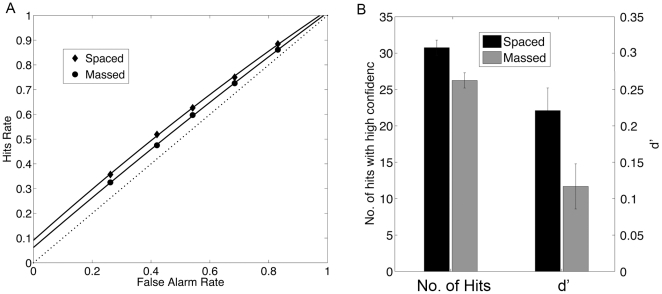
Behavioral effects of spaced learning.A. Receiver operator characteristic (ROC) curve plotted as hits rate against false alarm rate, separately for spaced and massed learning. B. Bars represent the mean number of hits with high confidence (rated as > = 5 in a 6-point scale with 1 indicating definitely new and 6 indicating definitely old), and the mean discriminablity index (d′) for spaced and massed learning in a recognition memory test administered 1 hour after the scan. Error bars represent within-subject standard error.